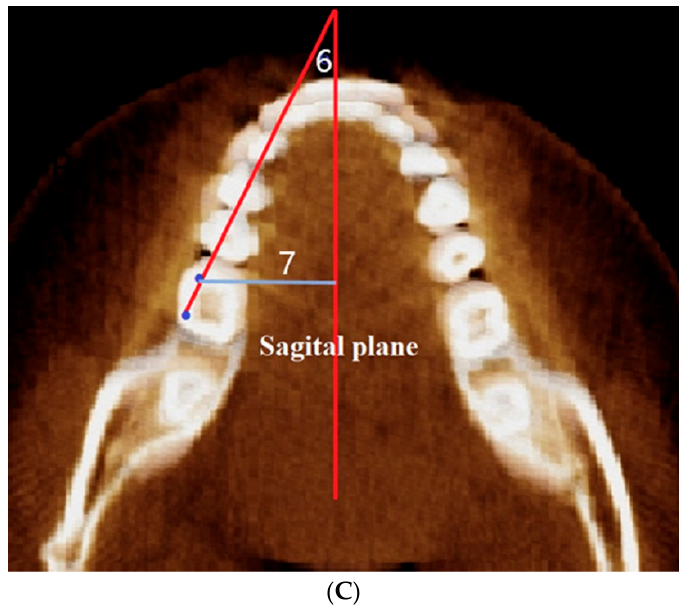
Figure 3. ( A ) Position of the mandibular right first molar: (1) Horizontal plane; (2); frontal plane; (3) the distance from the mesiobuccal cusp to the frontal plane (Z); (4) the distance from the mesiobuccal cusp to the horizontal plane (X). ( B ) Angulation of the mandibular first molar: (5) The angle between the long axis of the first molar (mesiobuccal cusp-mesial root tip) and the horizontal plane (X). ( C ) Rotation of the mandibular first molar: (6) The angle between the crown axis of the first molar (mesiobuccal cusp-distobuccal cusp) and sagittal (Y) plane projected on the horizontal (X) plane; (7) the distance from the mesiobuccal cusp to the sagittal (Y) plane. The angles were analyzed between sagittal plane projected on horizontal plane and the crown axis of molars, a line tangential to the MB and DB cusps. The change in rotation of maxillary molars was also measured (Figures 3C and 4).